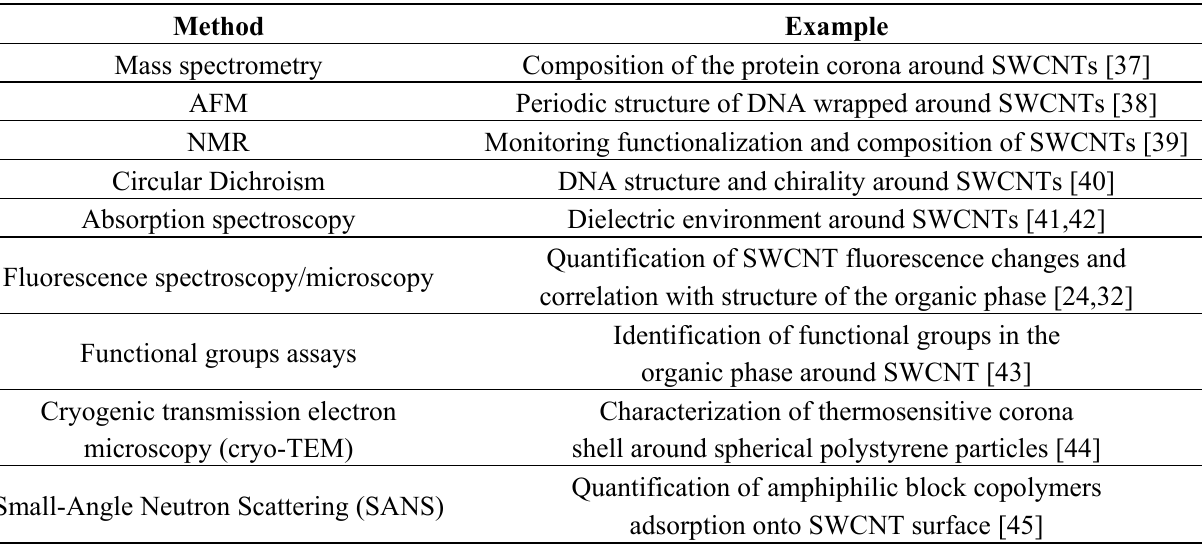
Table 1. Summary of methods commonly used to elucidate the structure of the corona phase around carbon nanotube